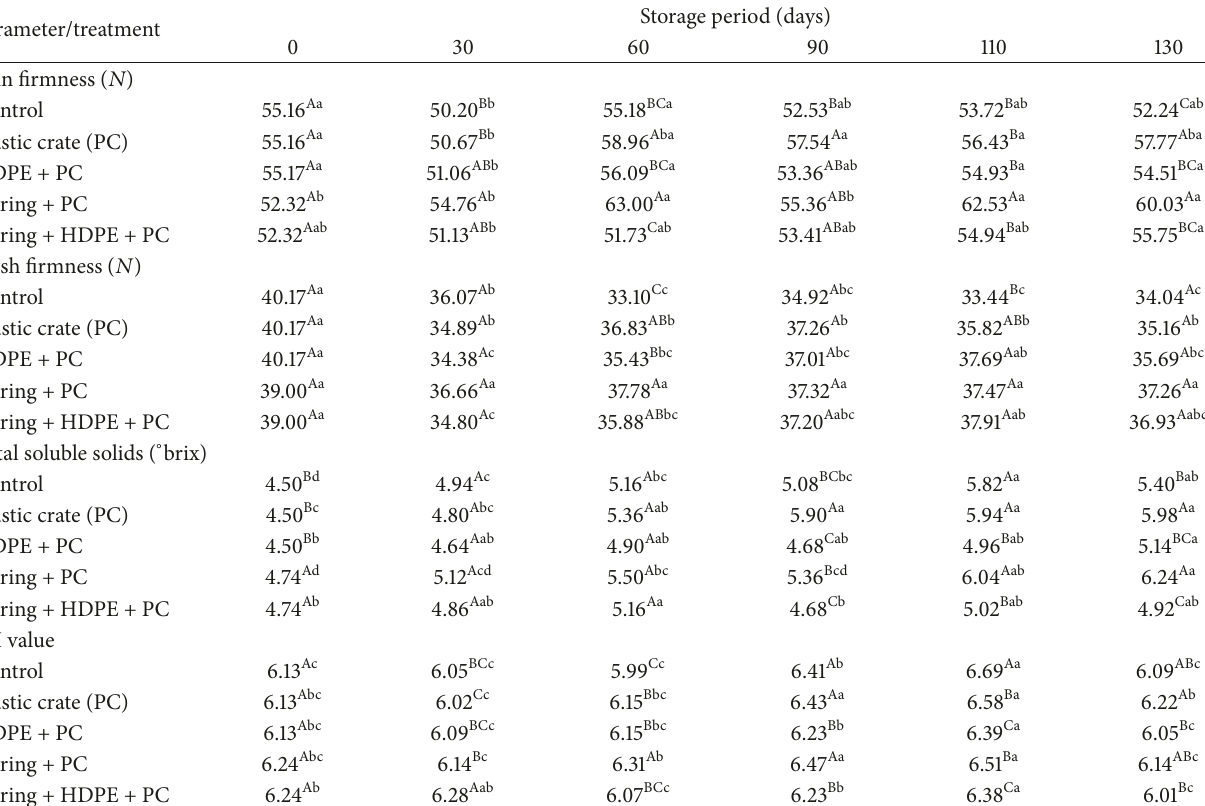
Table 1: Skin and flesh firmness, total soluble solids (TSS), and pH values of Korean radish roots under different packaging treatments during storage at 0 ∘ C for an extended